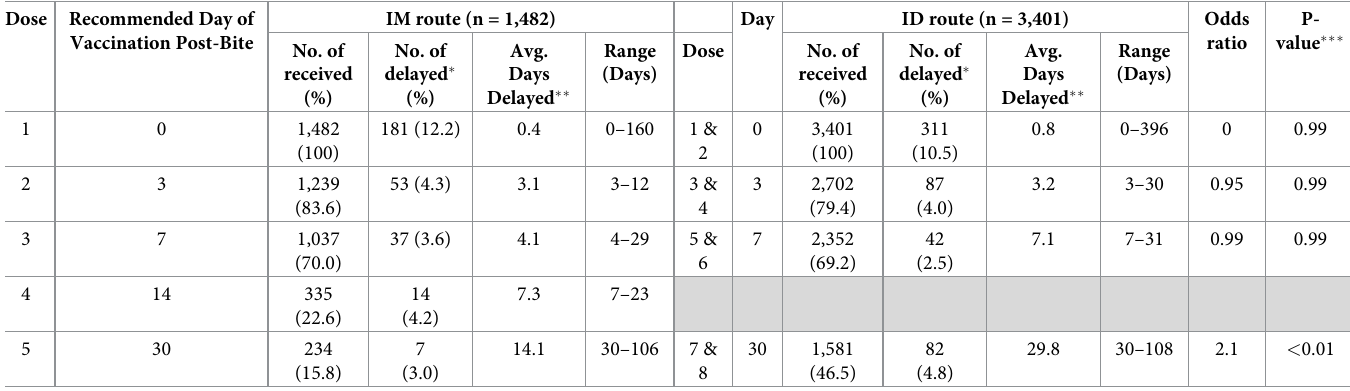
Table 5. Adherence to intramuscular and intradermal post-exposure prophylaxis among persons with category III exposures for whom 5-doses IM or 4-doses ID regimen of PEP was advised, 1 st Jan– 31 st Dec 2015. Dose Recommended Day of Vaccination